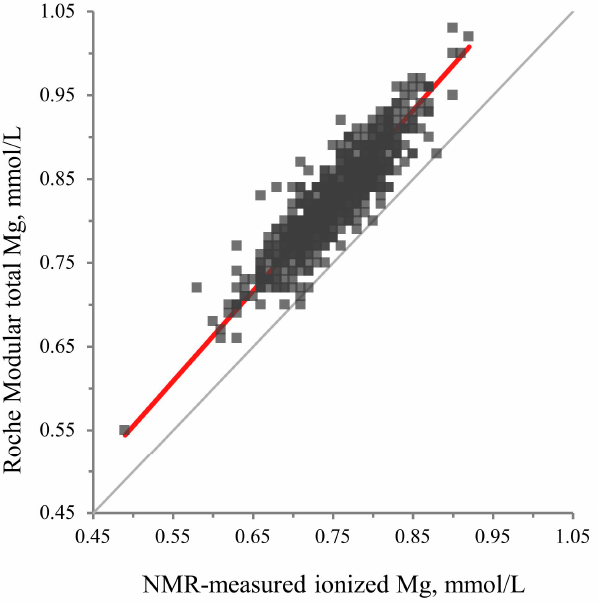
Figure 3. Passing–Bablok regression analysis.